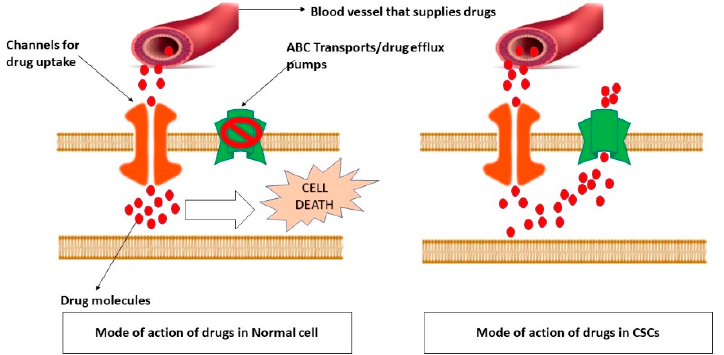
Figure 1. Underlying mechanism of drug resistance in CSCs. To survive in a harsh tumor microenvi- ronment and to withstand the cell death mechanisms CSCs alter the expression of several genes. ABC transporters are one among them which serve as drug efflux pumps. It is believed that upregulation of these drug exports makes CSCs to escape from the effects of anti-neoplastic drugs. This picture describes the mode of action of various drugs in normal cells and CSCs. Usually, under normal conditions, the drug efflux pumps are usually inactivated in the affected cell so that the drug that comes from the circulation would be easily absorbed by that cell with help of certain drug uptake channels. However, in CSCs due to overexpression of ABC transports, although the drug would be absorbed it would be immediately pushed back to the circulation.